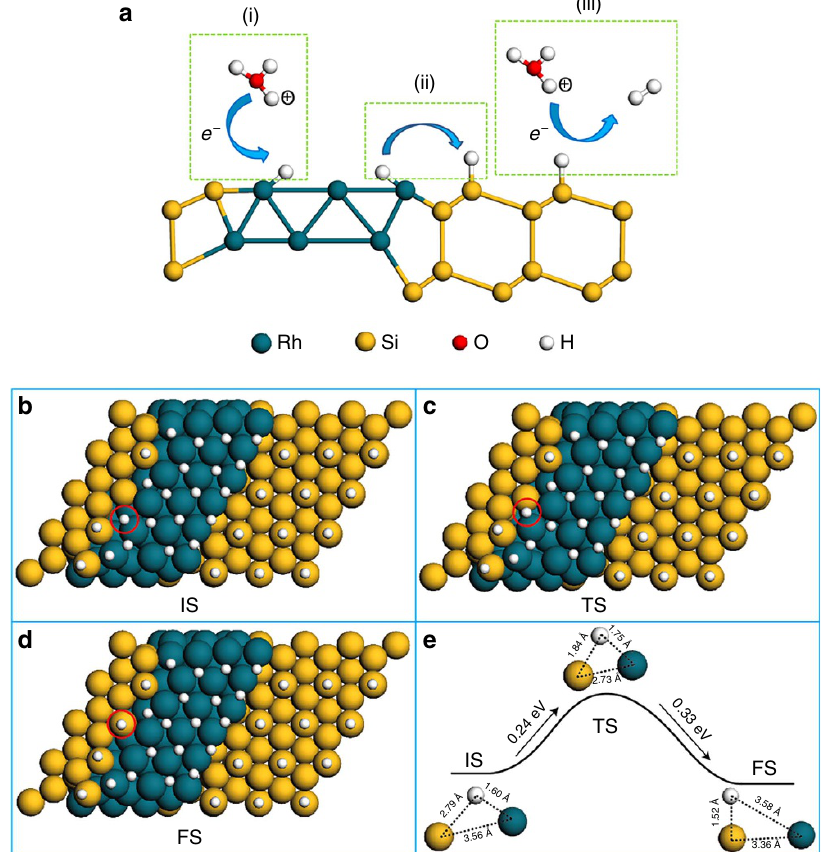
Figure 4 | Modelling of the HER reaction on Rh/SiNW. ( a ) A schematic representation of the HER reaction mechanism: (i) adsorption of hydrogen ions on the Rh surface. (ii) Diffusion of a hydrogen atom from the Rh surface to the Si surface. (iii) The adsorbed hydrogen atom on the Si surface reacts with a proton to form a hydrogen molecule. And the Rh-adsorbed hydrogen may migrate to the surface of Si atoms (marked with a red circle): ( b ) IS, initial state; ( c ) TS, transition state; and ( d ) FS, final state. ( e ) The activation energy to get to the transition state is 0.24eVand in the final state the adsorbed hydrogen is 0.33eV below the transition state and 0.09eV below the initial state. kinetics among all electrocatalysts studied, since a smaller Tafel for small slopes the current gain with potential increase would be slope signifies a more rapid increase of the HER rate with larger. increasing overpotential. The above discussion shows that Rh/ The Tafel slopes (Fig. 2d) for SiNW-, pure Rh- and Pt/C- SiNW not only has a catalytic activity comparable to Pt/C at low modified GC electrodes derived from Fig. 2c are 145 (inset), 40 overpotentials (0 to (cid:2) 160 mV), but also is an excellent catalyst, and 30 mV dec (cid:2) 1 , respectively, whereas the Tafel slope of Rh/ even better than Pt/C in practical working potentials (more SiNW catalysts is as low as 24 mV dec (cid:2) 1 . The Tafel slopes (Fig. 2d) show the 29.1 wt% Rh/SiNW to have the best HER negative than (cid:2) 160 mV versus RHE).